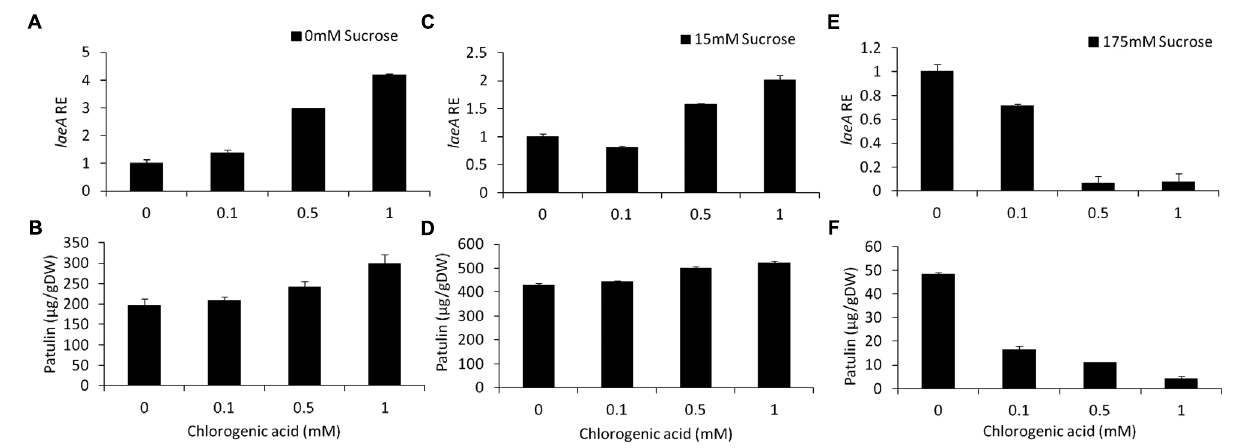
FIGURE 6 | Effect of chlorogenic acid in absence and presence of different sucrose levels on relative gene expression and patulin accumulation. Solid SM media at initial pH 5.0 were amended with 0, 15, 175 mM sucrose and combined with chlorogenic acid at concentrations ranging from 0 up to 1 mM. The effect of the combination of sucrose/chlorogenic was tested on laeA relative expression (RE) (A,C,E) and patulin accumulation (B,D,F) . The media was inoculated with 100 µ l of a 10 6 spore/ml suspension. RE of laeA and patulin accumulation were evaluated on the third day post-inoculation. Five 10-mm diameter disks were sampled from five independent culture plates. Average values ( ± SE) of five replicates are reported. Experiments were repeated three times and results of a single representative experiment are shown.